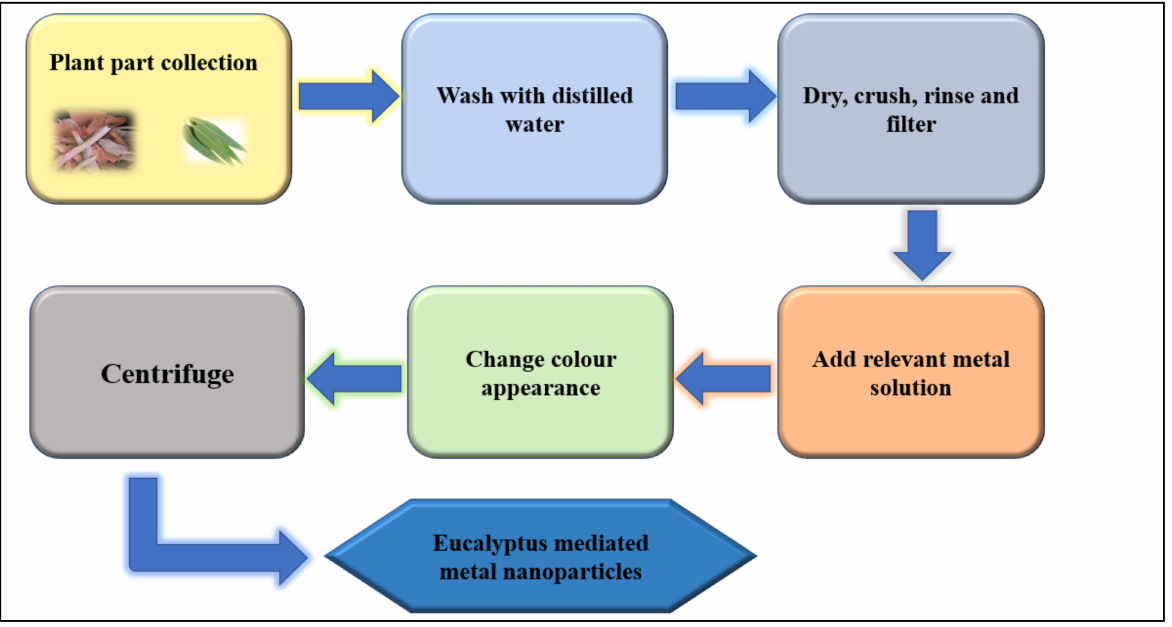
Figure 5. Schematic mechanism of synthesis MNPs from Eucalyptus . Starting from the collection of plant parts, then going through several steps, and ending with filtration to reach the extraction. After that, the extract is used to reach the targeted MNPs after mixing it with the metal ion solution to observe the changed color, which indicates the procedure’s